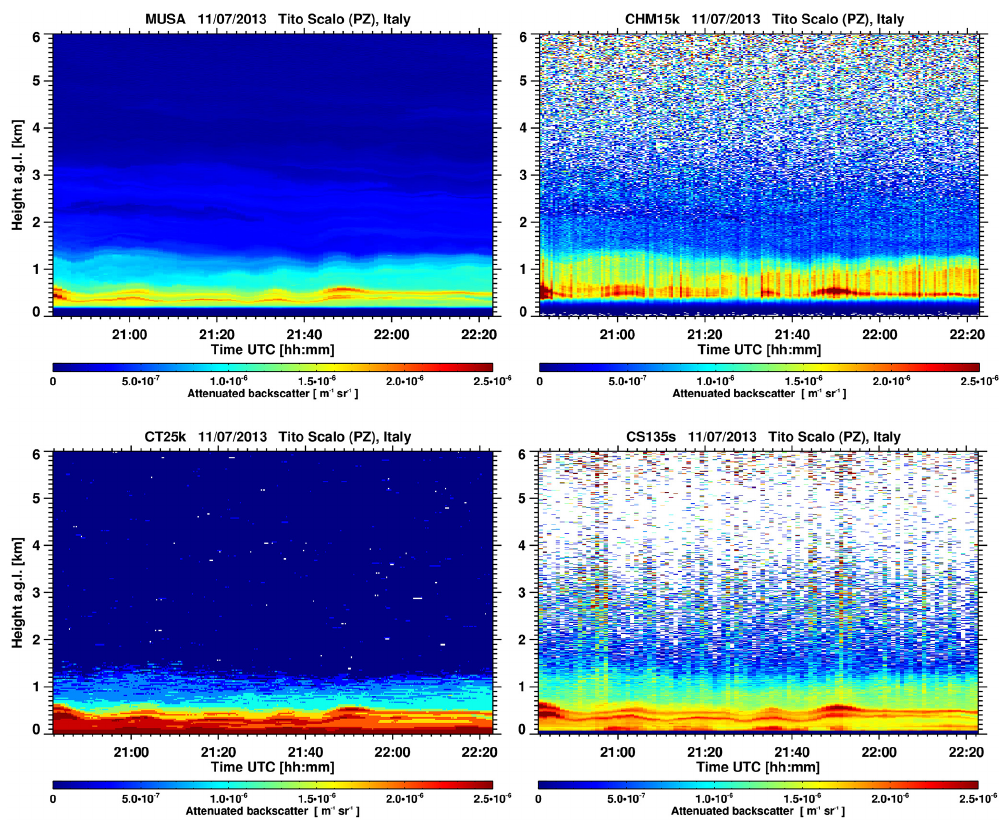
Figure 7. Observation time series of attenuated backscatter coefficient collected on 11 July 2013 from 20:42 to 22:22UTC with MUSA and CHM15k at 1064nm, and with CT25K and CS135s at